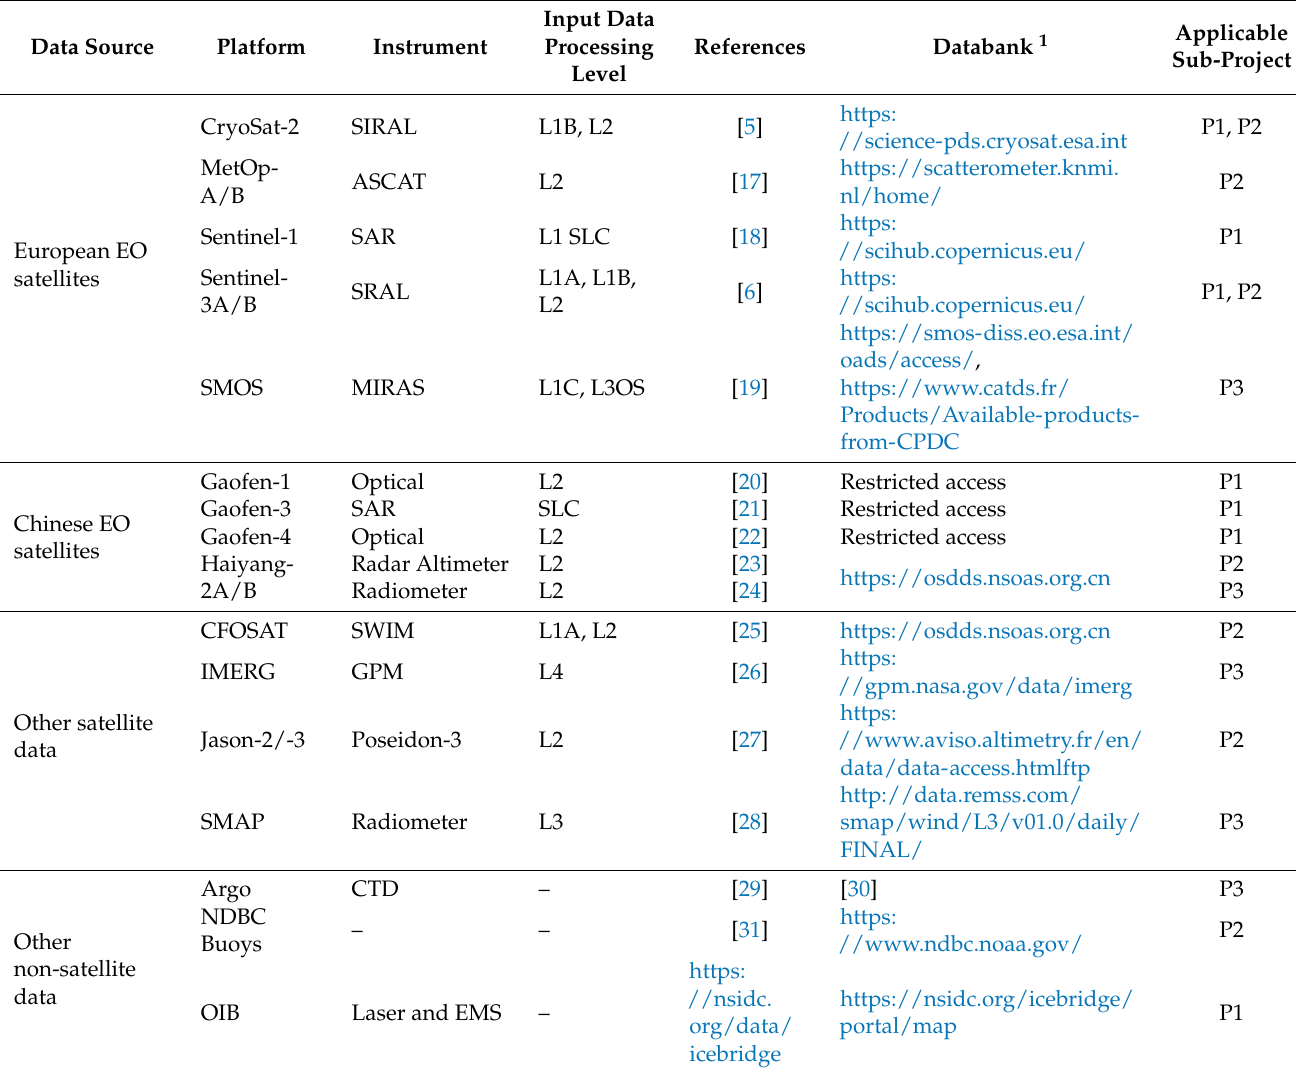
Table 2. Earth Observation (EO) satellite data